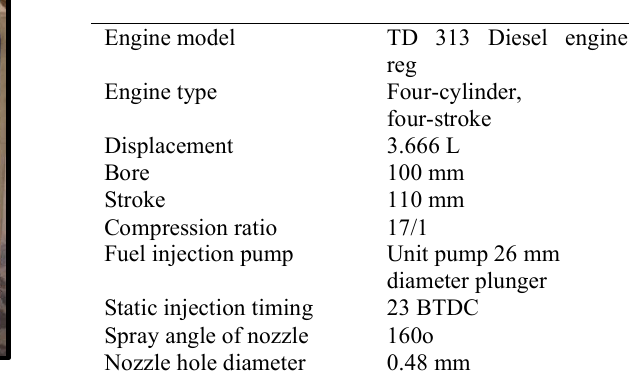
Tested Engine Specification.